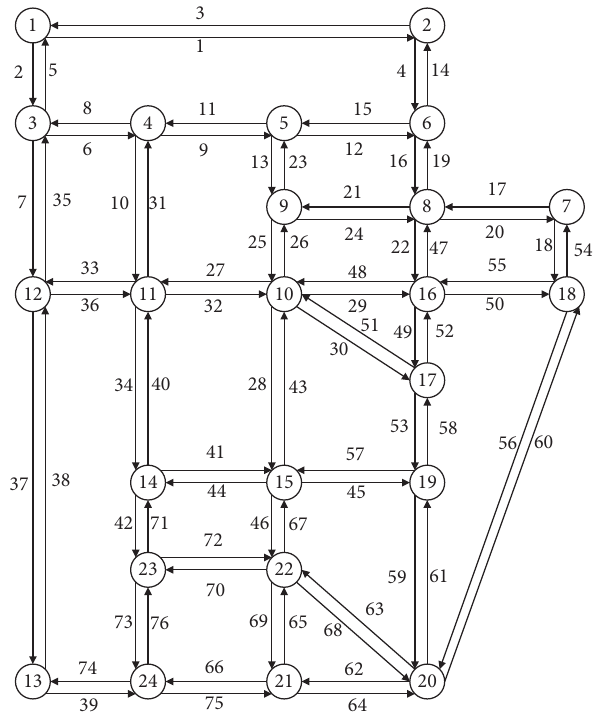
Figure 1: Sioux-Falls